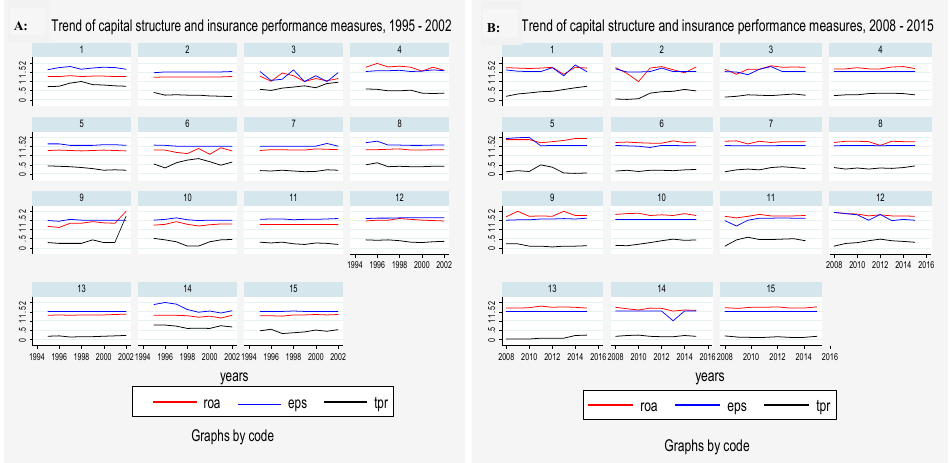
Figure 4. Graphs of the trend of panel variables between 1995–2002 and 2008–2015. From the above figure, panel trend indicating relative stationarity of key variables: ROA, EPS and TPR during NRBC regime (1995–2002) and RBC regime (2008–2015) are illustrated in Figure